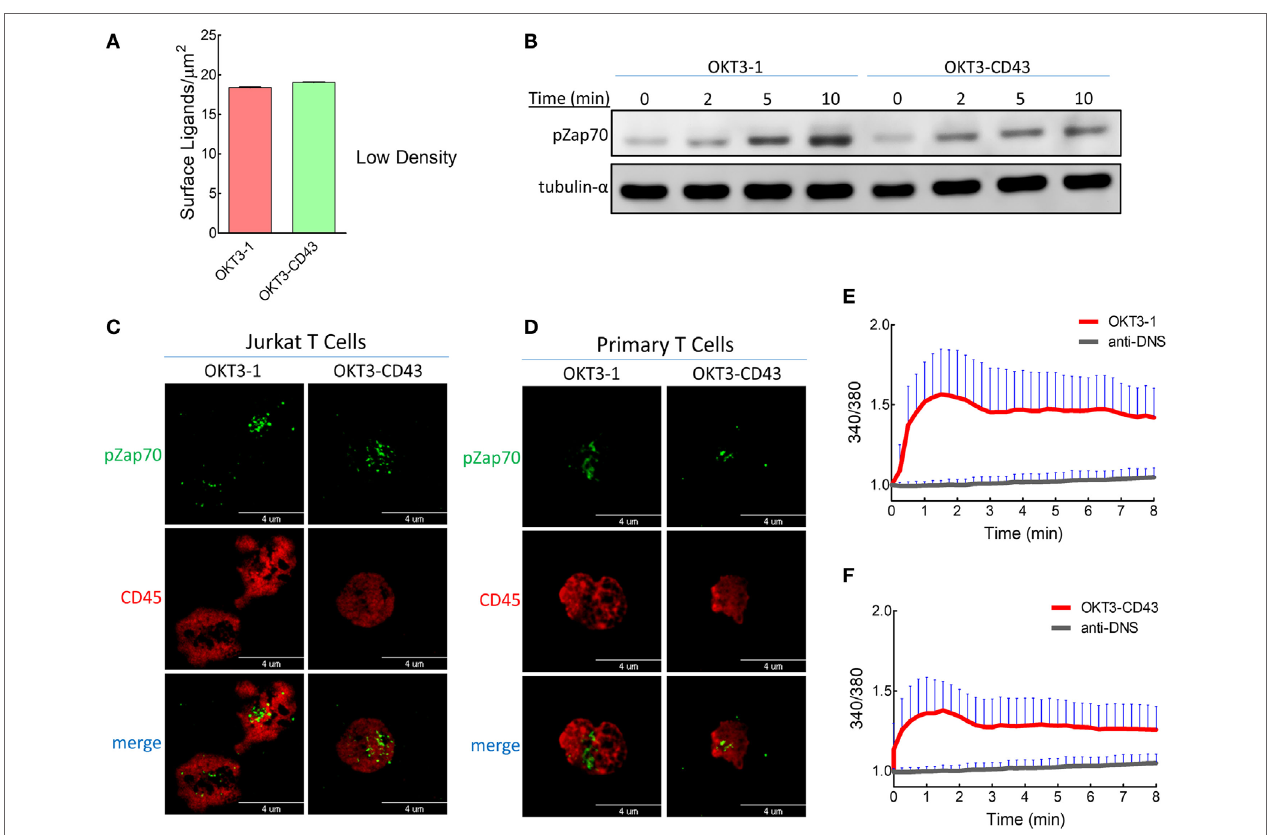
FigUre 8 | T cell receptors can be triggered by low densities of high-affinity ligands. (a) The estimated densities of anti-CD3 scFv were measured by comparing fluorescent intensities of anti-CD3 scFv on lipid bilayer-coated glass beads relative to standard beads with known amounts of surface antibodies. (B) Zap70 phosphorylation was detected from lysates of activated Jurkat T cells with low ligand densities (as in Figure 8a ) displayed over lipid bilayer-coated glass beads and at different times. (c) TIRF images for Jurkat T cells on lipid bilayers with low ligand densities (as in Figure 8a ). Cells were stained for pZap70 and CD45 after 3 min of contact with activating ligands on lipid bilayers. (D) TIRF images of freshly isolated human T cells on lipid bilayers with low ligand densities (as in Figure 8a ). Cells were stained for pZap70 and CD45 after 3 min of contact with activating ligands on lipid bilayers. Ca 2 + flux measured from Fura-2AM stained Jurkat T cells on a lipid bilayer with low densities (as in Figure 8a ) of (e) OKT3-1 or (F) OKT3-CD43 as well as anti-DNS control scFv ( n = 25 cells per ligand). Bars,